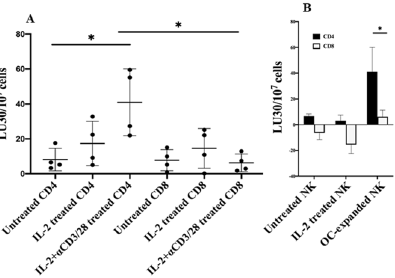
Figure 7. NK cells preferentially lyse CD4 + T cells and not CD8 + T cells. Freshly purified CD4 + T and CD8 + T cells from healthy individuals were left untreated, treated with IL-2 (100 U/ml), or treated with a combination of IL-2 (100 U/ml) and anti-CD3 (1 µg/ml)/CD28mAb (3 µg/ml) for 18 h. NK cells which were treated and co-cultured with OCs as described in Fig. 1A, were used to determine cytotoxicity against CD4 + and CD8 + T cells using a TVA dye assay. LU 30/10 7 cells were determined using the inverse of the number of NK cells required to lyse 30% of target cells × 1000 (n = 4) (A) . NK cells were left untreated or treated with IL-2 (1000 U/ ml) for 18 h, or expanded with OCs as described in Fig. 1A, and used to determine cytotoxicity against IL-2 (100 U/ml) and anti-CD3 (1 µg/ml)/CD28mAb (3 µg/ml) Treated CD4 + and CD8 + T cells using a TVA dye assay. LU 30/10 7 cells were determined as described in Fig. 7A. One of several representative experiments is shown in the figures (B)